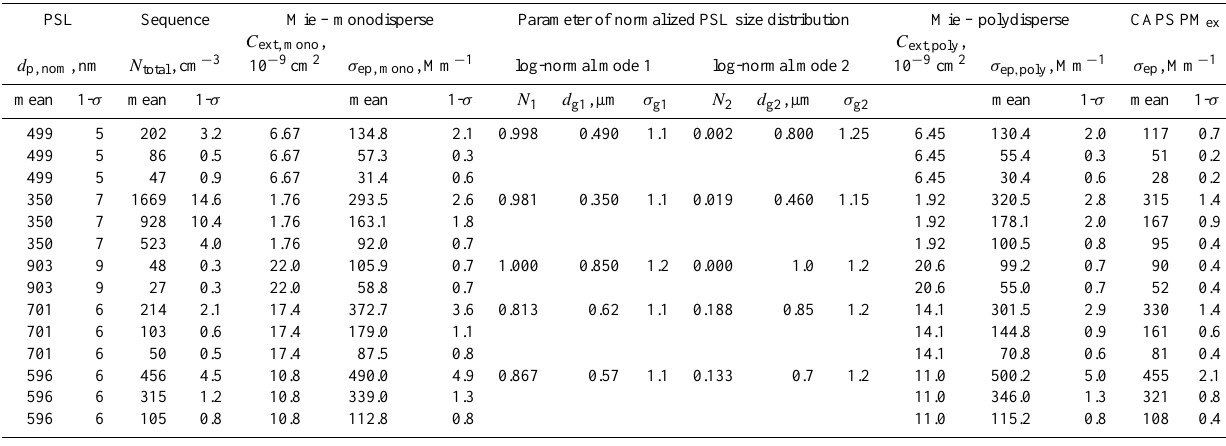
Table 2. Data used for the pathlength adjustment of CAPS PM ex *. PSL